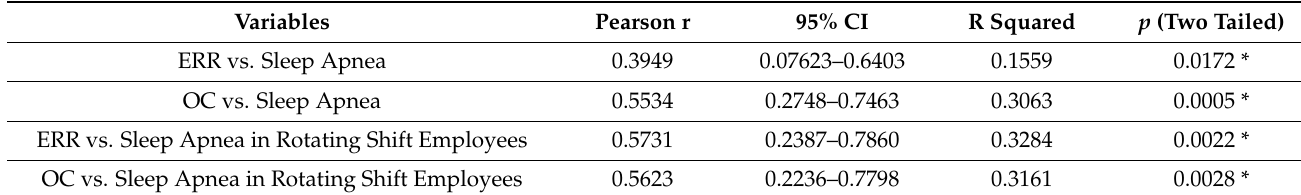
Table 4. Showing correlation between rotating shift and sleep apnea in participants.